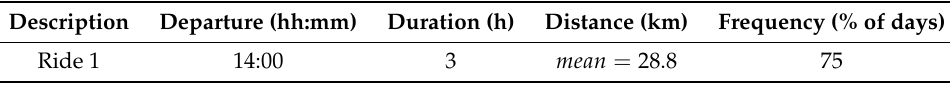
Table A2. Primary EV schedule for a holiday or